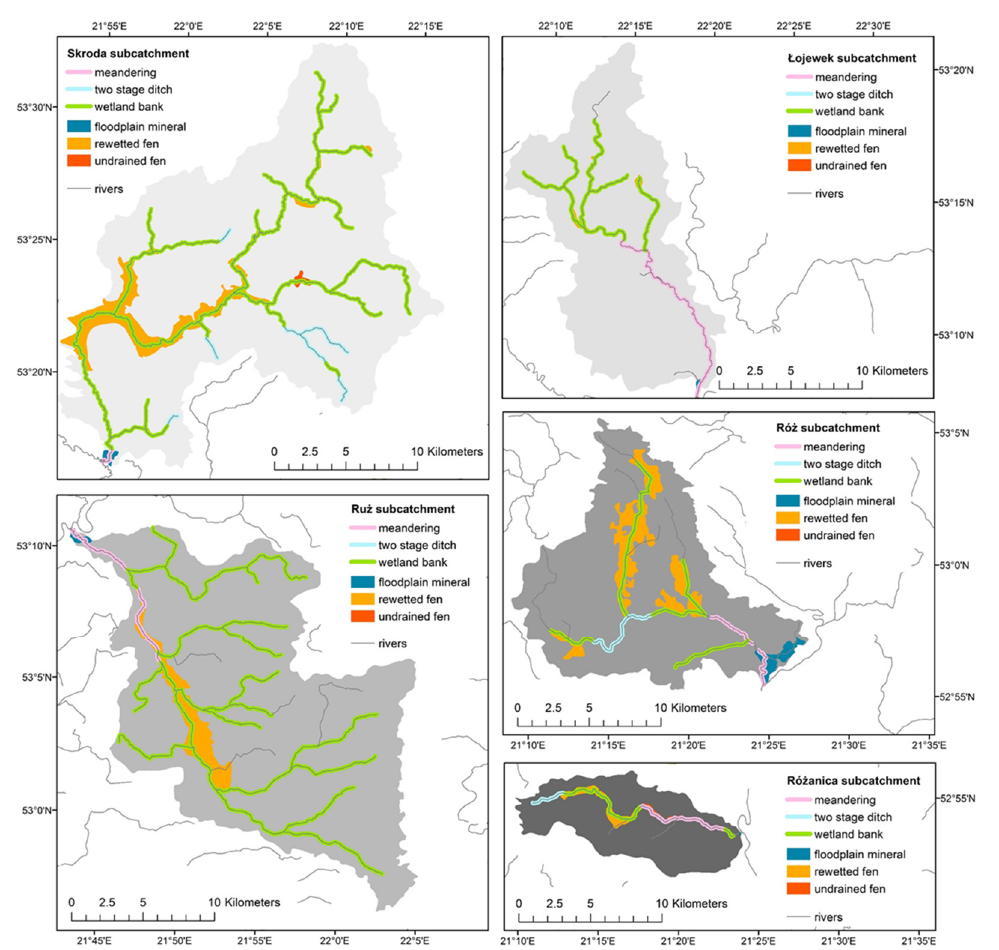
Figure 2. Wetland buffer zone (WBZ) types delineated in sub-catchments.